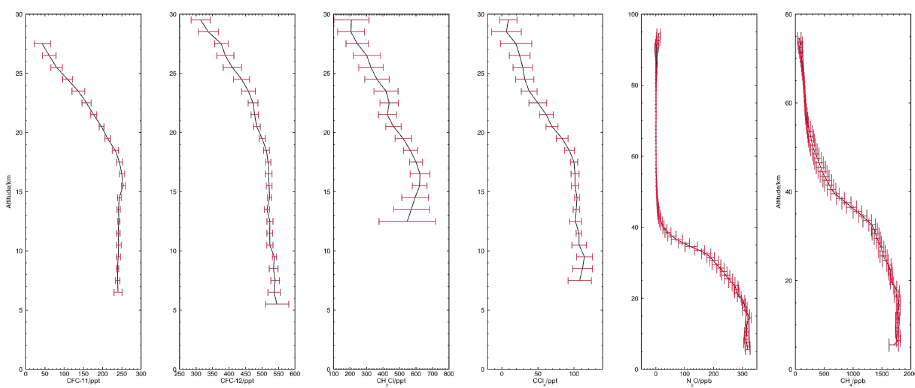
Figure C6 The mean vertical profile of CFC-11, CFC-12, CH3Cl, CH4 & N2O, calculated using data from 2009 between 15° and 0° North Fig. C7. The mean vertical profile of CFC-11, CFC-12, CH 3 Cl, CCl 4 , N 2 O and CH 4 , calculated using data from 2009 between 15 ◦ and 0 ◦